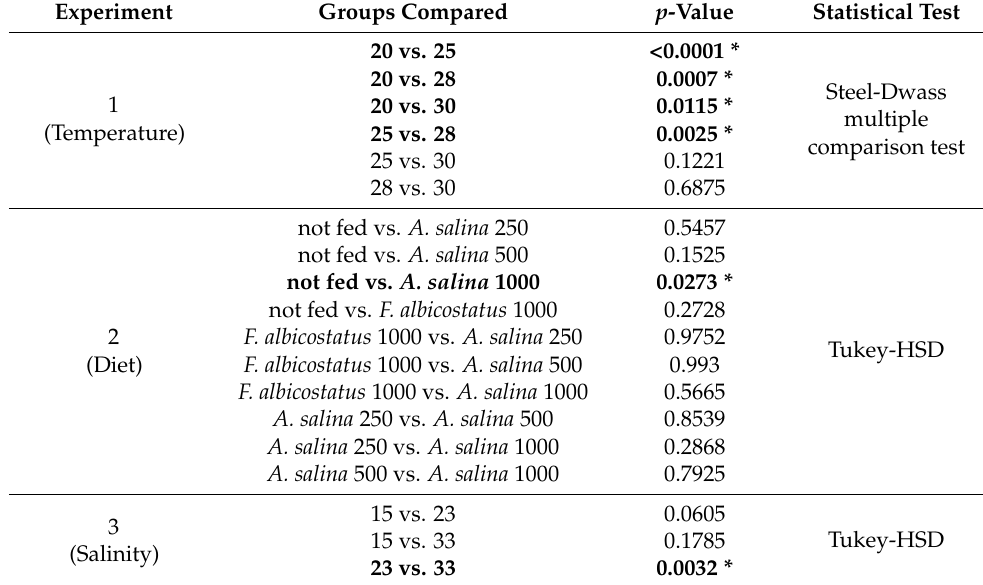
Table 4. Statistical comparisons of the effect of temperature, diet, and salinity conditions on the population growth of sea anemone A. minuta during the 10–14-day culture period. Treatments with a p -value < 0.05 were considered significant and highlighted in bold and with an asterisk